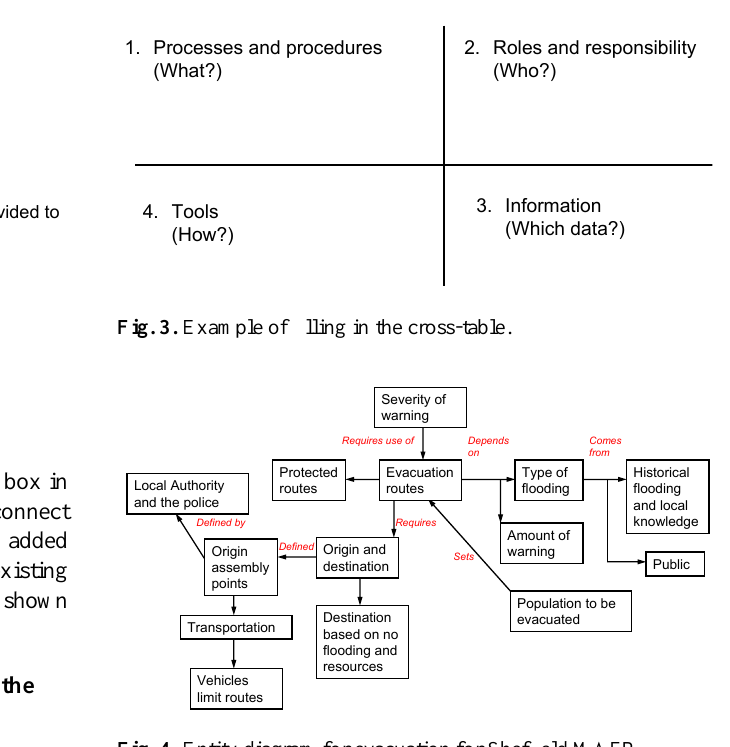
Fig. 4. Entity diagram for evacuation for Sheffield